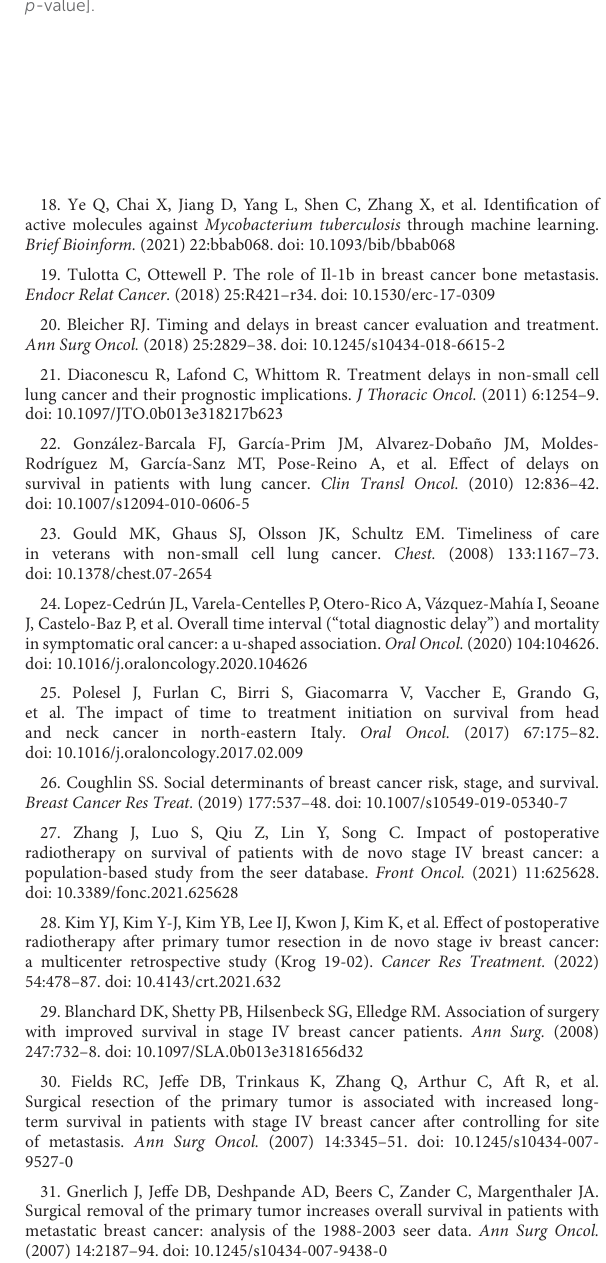
clinical characteristics in terms of importance in the 3-year prognostic model. (C) The ranking of clinical characteristics in terms of importance in the 5-year prognostic model. XGBoost, extreme gradient